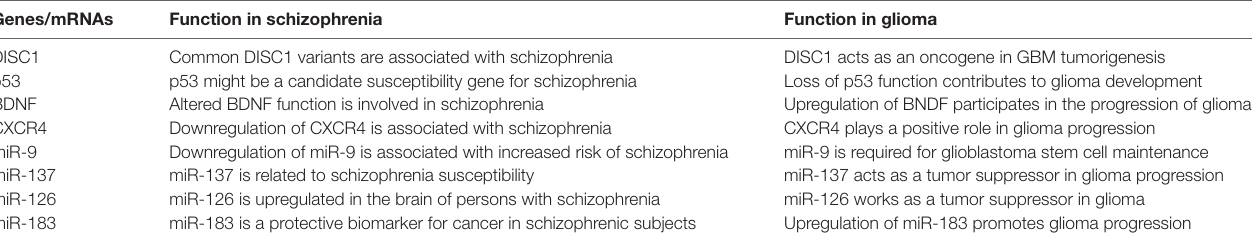
TABLE 2 | List of genes and microRNAs (miRNAs) involved in glioma tumorigenesis and schizophrenia.